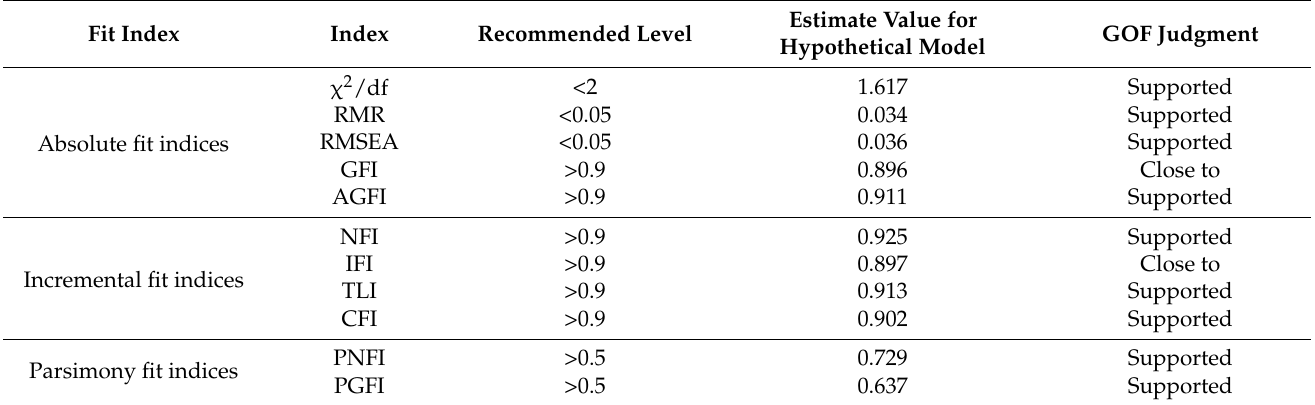
Table 5. Goodness of fit measures of SEM